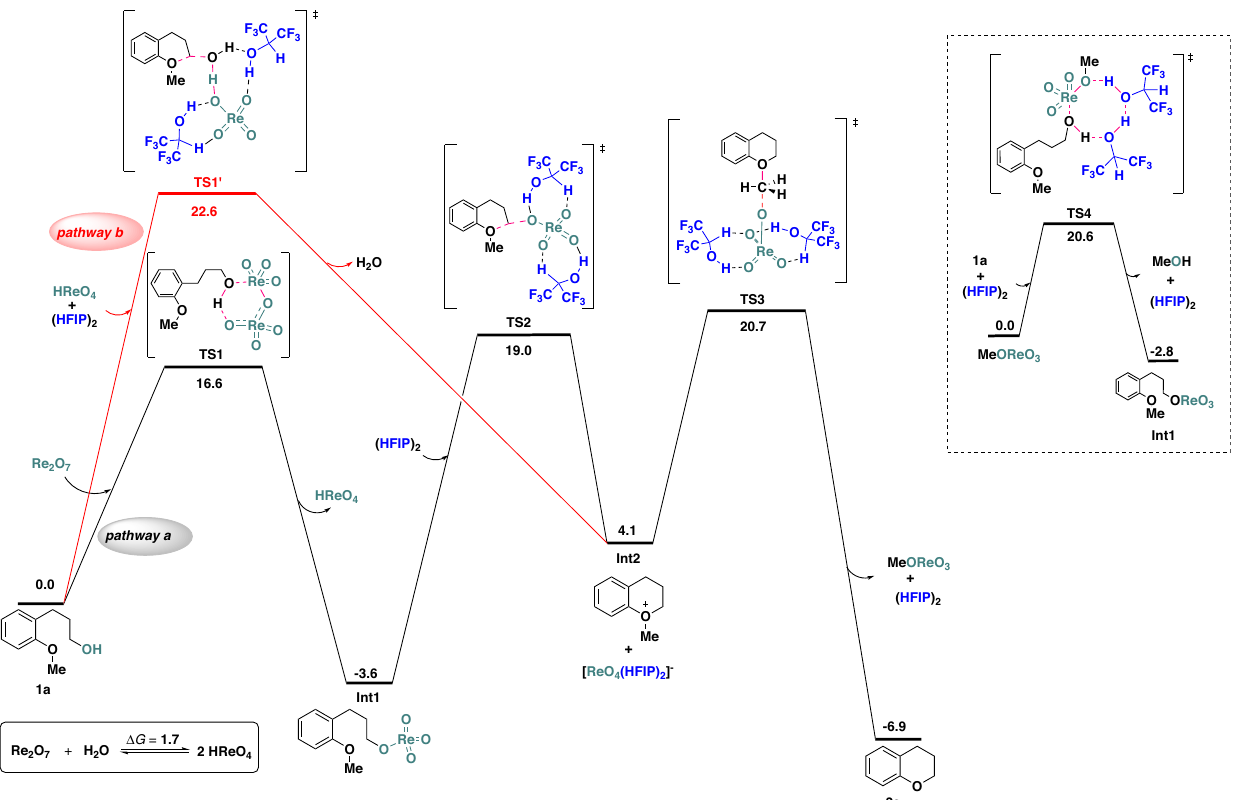
Fig.5|Computedenergypro fi leoftheproposedmechanism. Gibbsfreeenergypro fi le(kcal/mol)attheSMD-B3LYP-D3/def2-TZVPP//B3LYP-D3/def2-SVP-SDD(Re)level for the ring-closing C – O/C – O σ -bond metathesis of 1a catalyzed with Re 2 O 7